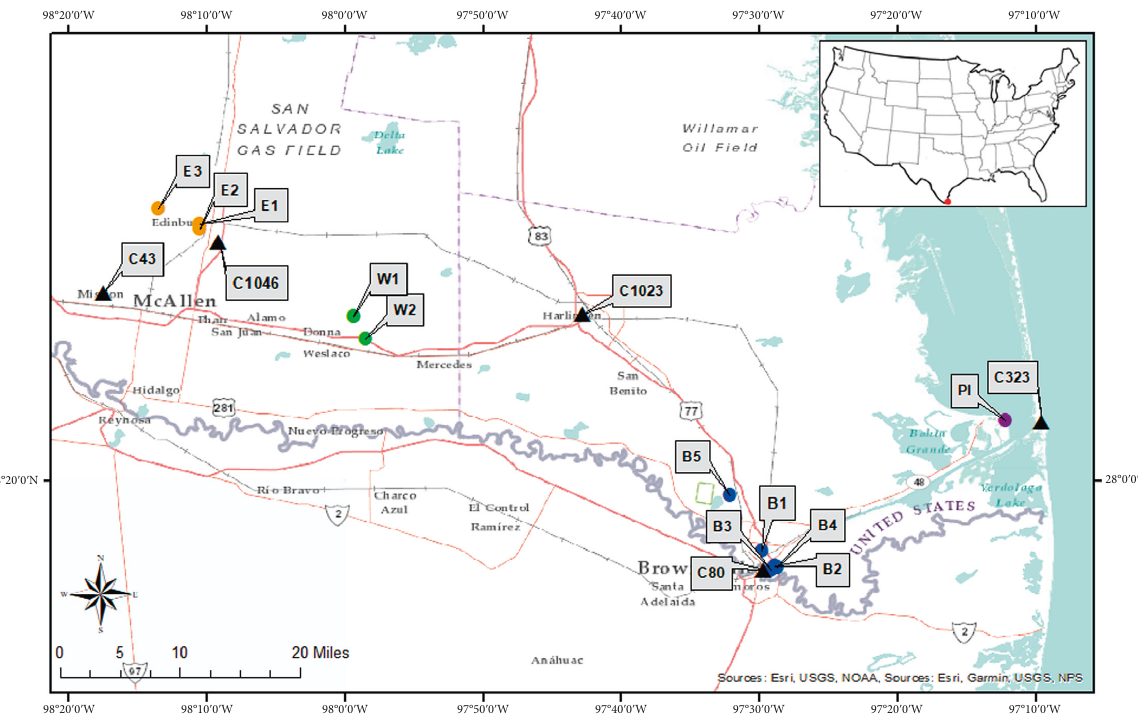
Figure 1: Map of Texas commission on environmental quality (TCEQ). Continuous ambient monitoring station (CAMS) sites and BlueSky air quality monitors throughout the study area in the lower RGV